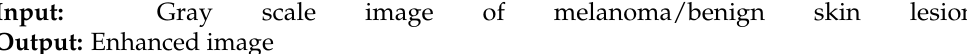
Algorithm 2 Fuzzy Relational